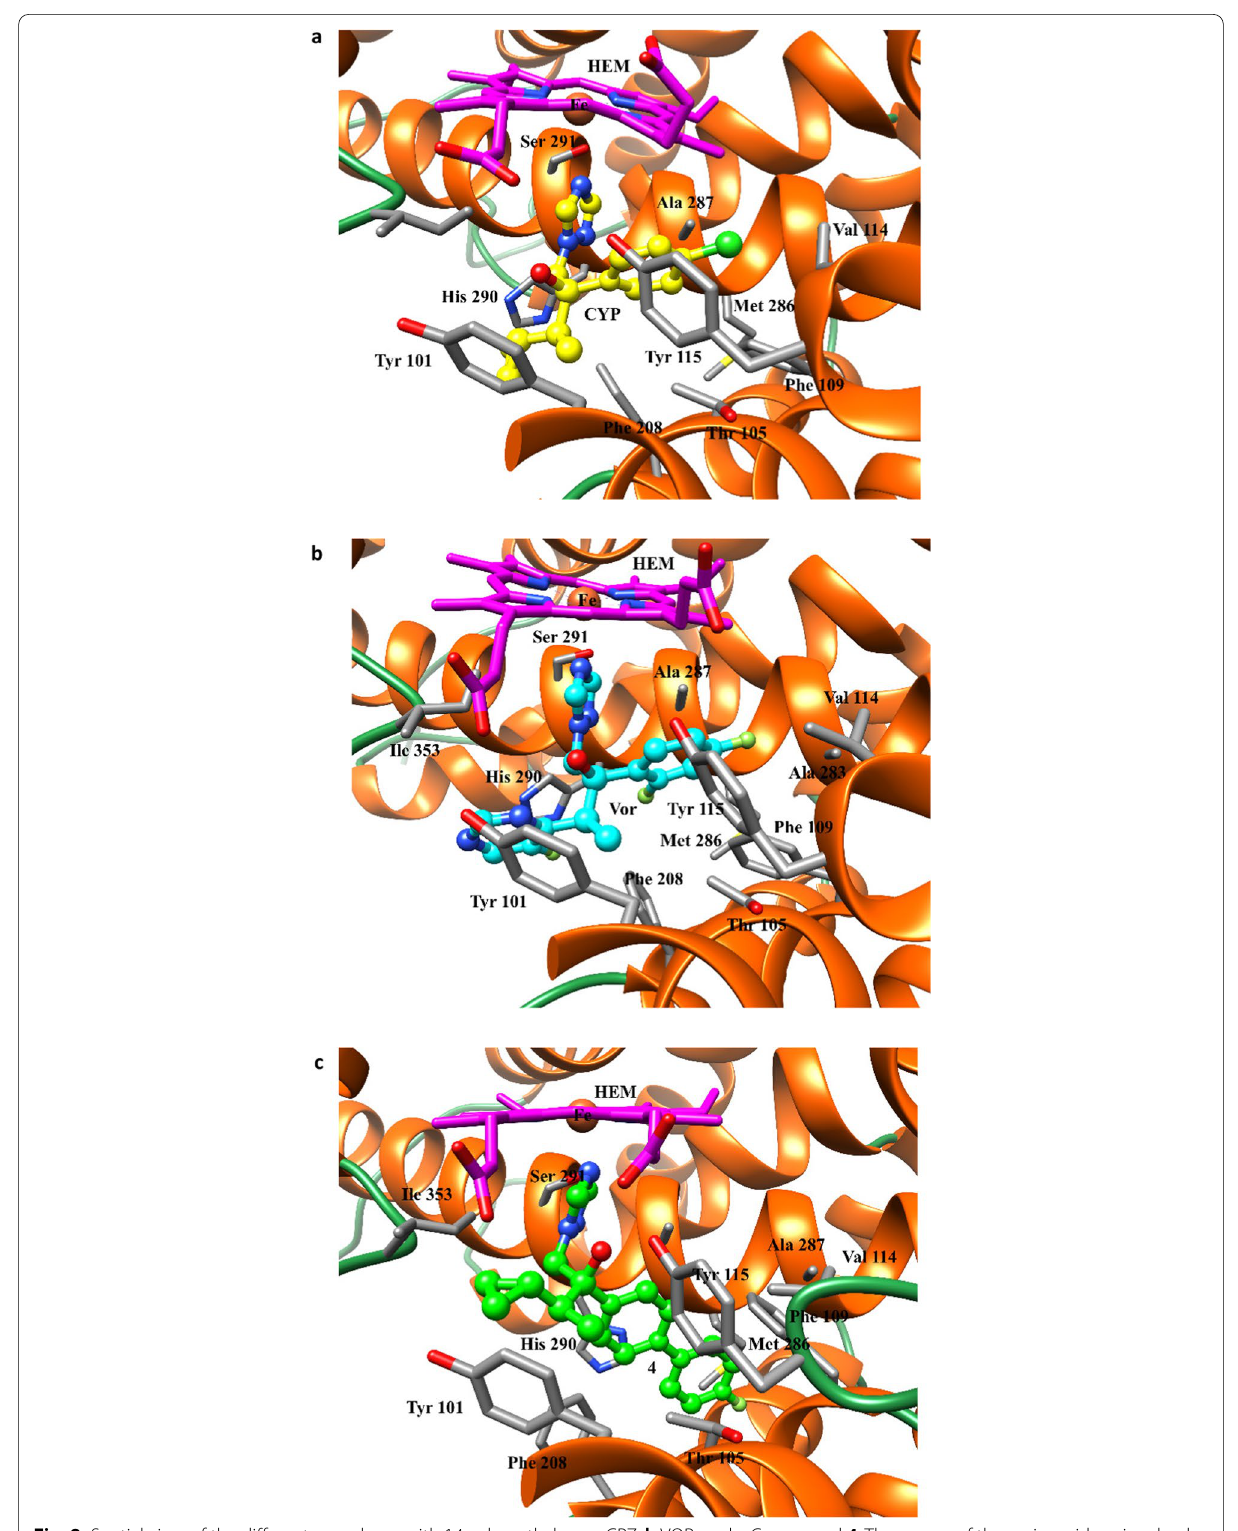
Fig. 8 Spatial view of the different complexes with 14α‑demethylase: a CPZ; b VOR, and c Compound 4 . The names of the main residues involved in the stabilizing interactions are shown in the